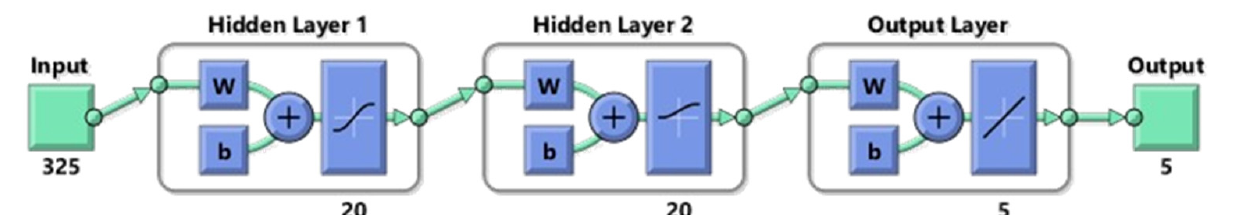
Figure 8. ANN image structured to detect the quality properties of apples with hyperspectral imaging.